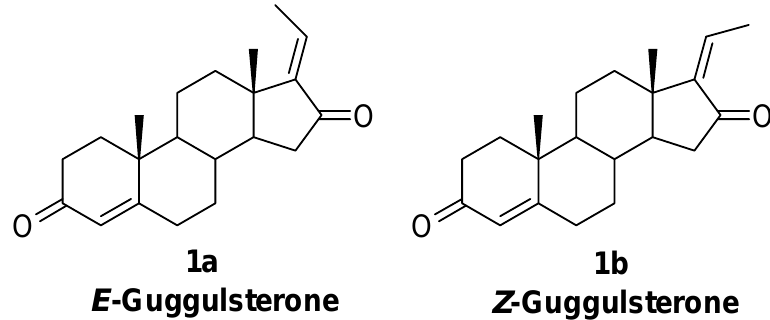
Figure 1. Chemical structures of E - and Z